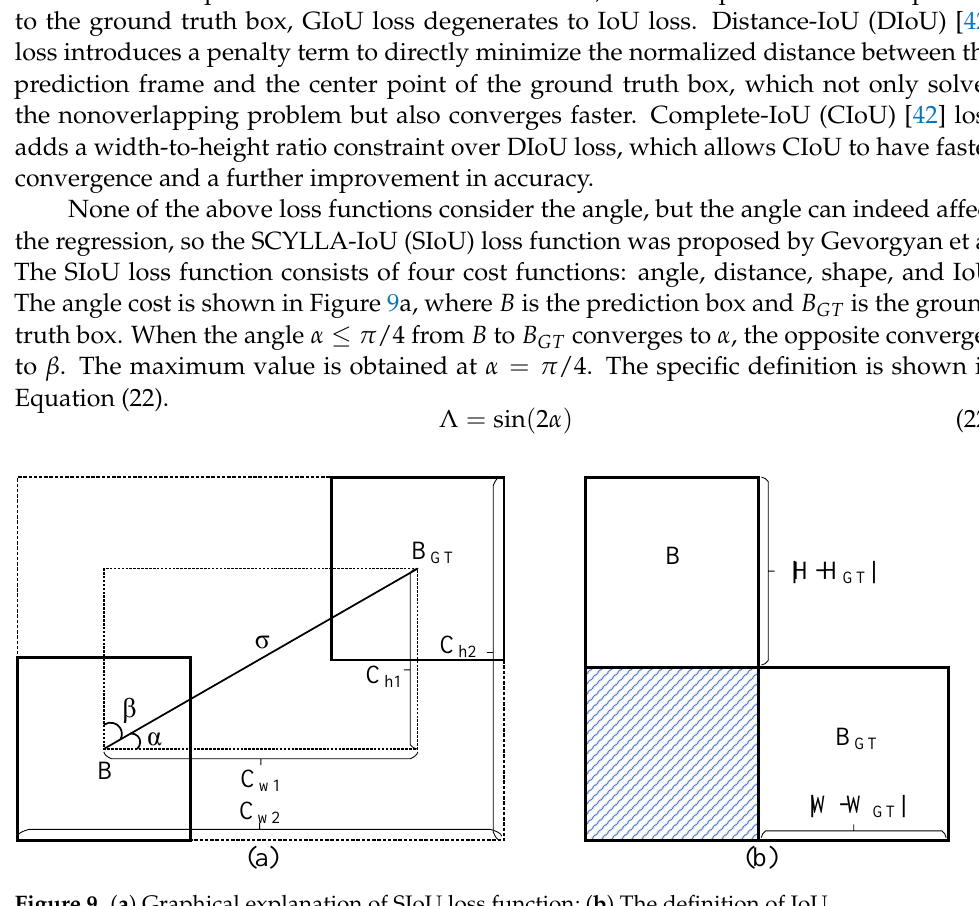
Figure 9. ( a ) Graphical explanation of SIoU loss function; ( b ) The definition of